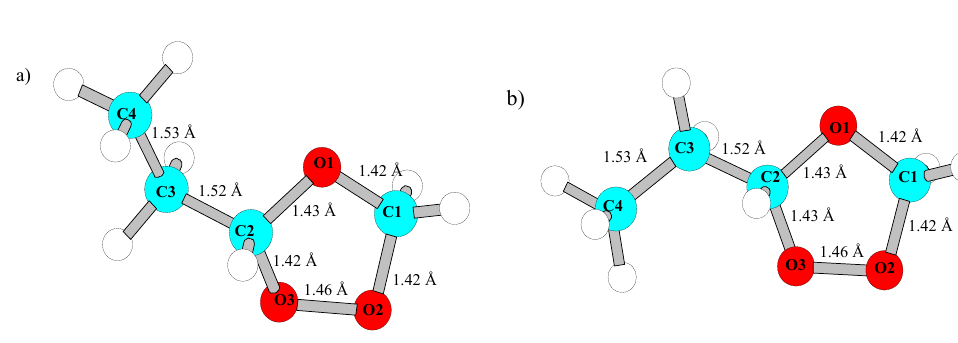
Fig. 5 Theoretically (B3LYP 6-311++G (3df, 3pd)) calculated structure of the most stable 1-butene SOZ conformers: a) gauche conformer: ∠ O1C2C3C4=-66.1 ◦ ; b) anti conformer: ∠ O1C2C3C4=-177.6 ◦ . The enthalpy difference between them δH = -0.31 kJ/mol.